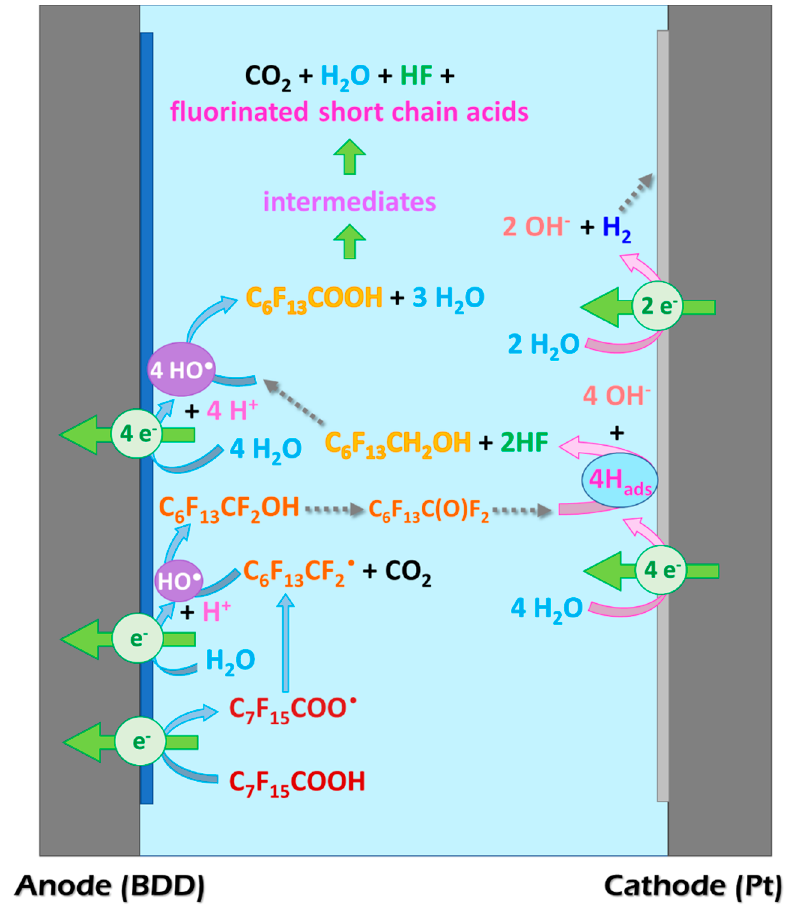
Figure 2. PFOA electrooxidation mechanism.